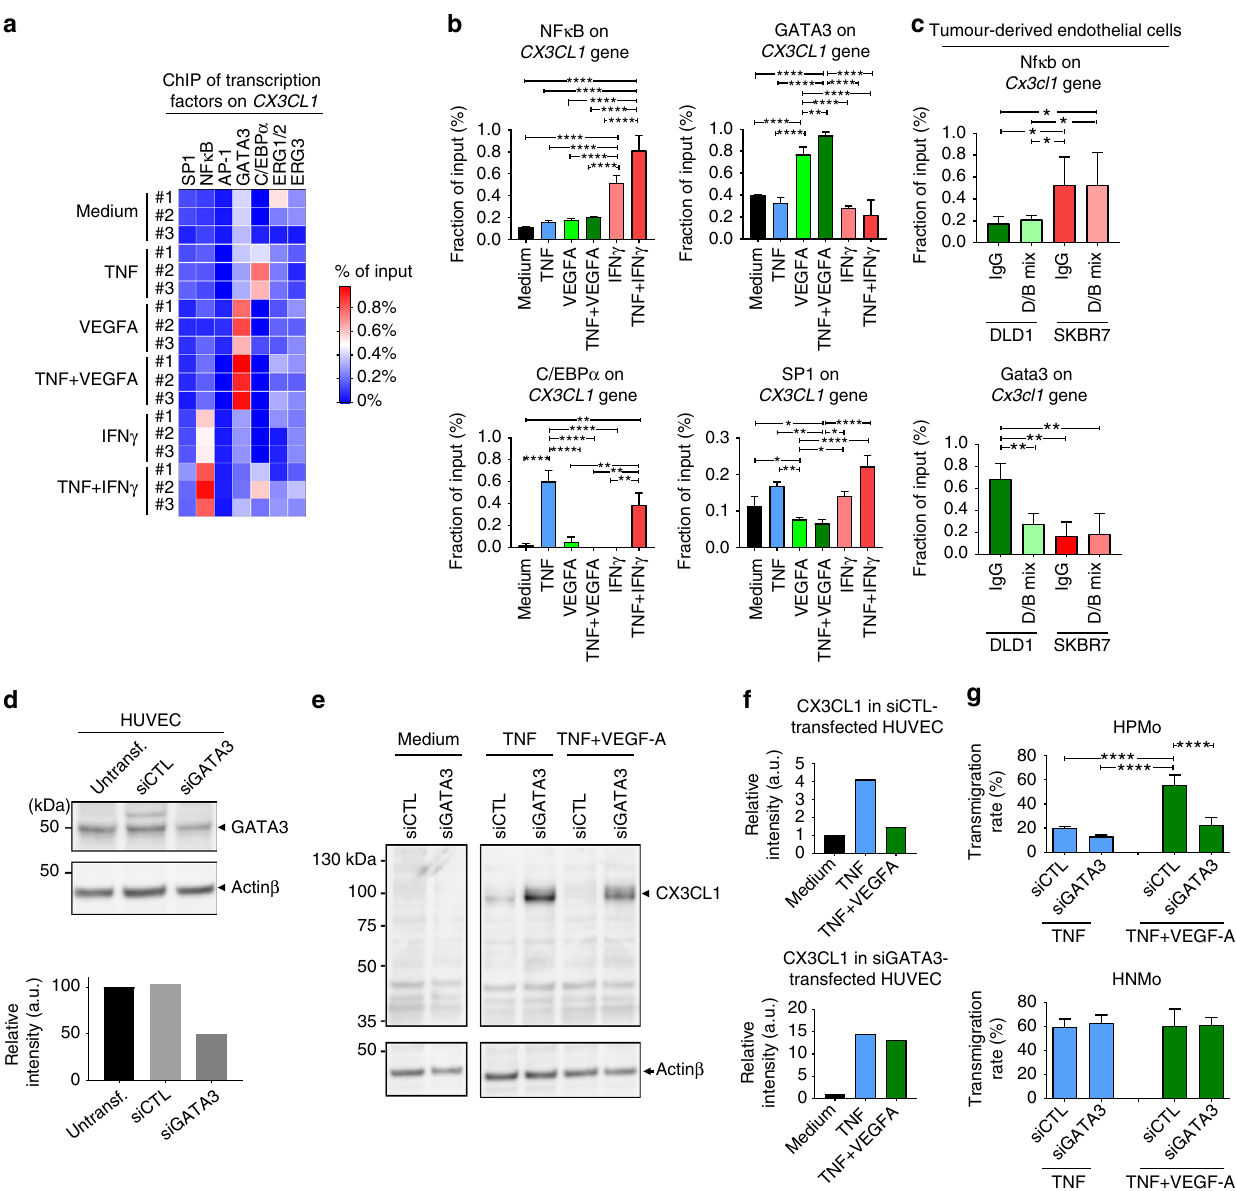
Fig. 8 VEGF-A promotes GATA3-mediated alteration of CX3CL1 expression and HPMo homing. a Heat map of the in fl uence of in fl ammatory conditions on transcription factor binding to the promoter of CX3CL1 in HUVECs. HUVECs were stimulated with in fl ammatory regimens, then chromatin immunoprecipitation (ChIP) was performed with antibodies against indicated transcription factors and immunoprecipitated DNA fragments in parallel with total input DNA were analysed. Analysis was done by qPCR for the presence of the CX3CL1 promoter. The result is presented as percentage of input DNA. The data represent individual mean values of experimental replicates (3 experiments #1 to #3). b Analysis of the effect of in fl ammatory conditions on the binding of candidate transcription factors to the CX3CL1 promoter from a . Data are presented as mean ± s.d. ( n = 3 experiments). c Analysis of the binding of Nf κ b and Gata3 to Cx3cl1 promoter in tumour associated endothelial cells. DLD1 and SKBR7 xenograft-bearing mice were treated either with the mixture of DC101 and bevacizumab (D/B mix) or control IgG for 24 h. Mice were killed, and tumours collected to isolate endothelial cells for ChIP analysis of Nf κ b and Gata3. Data are presented as mean ± s.d. of experimental replicates ( n = 3). d Analysis of GATA3 downregulation in HUVEC with speci fi c siRNA by western blotting and quanti fi cation. e Effect of GATA3 downregulation on CX3CL1 protein expression induced by TNF and TNF + IFN γ in HUVECs. f Quanti fi cation of GATA3 expression in e . g Role of GATA3 in HPMo transmigration induced by angiogenic factors-driven in fl ammation. The data are presented as mean ± s.d. of three independent experiments. * p < 0.05, ** p < 0.001, **** p < 0.0001, in ANOVA for b , c and g , analysis with Holm-Sidak adjustment for multiple